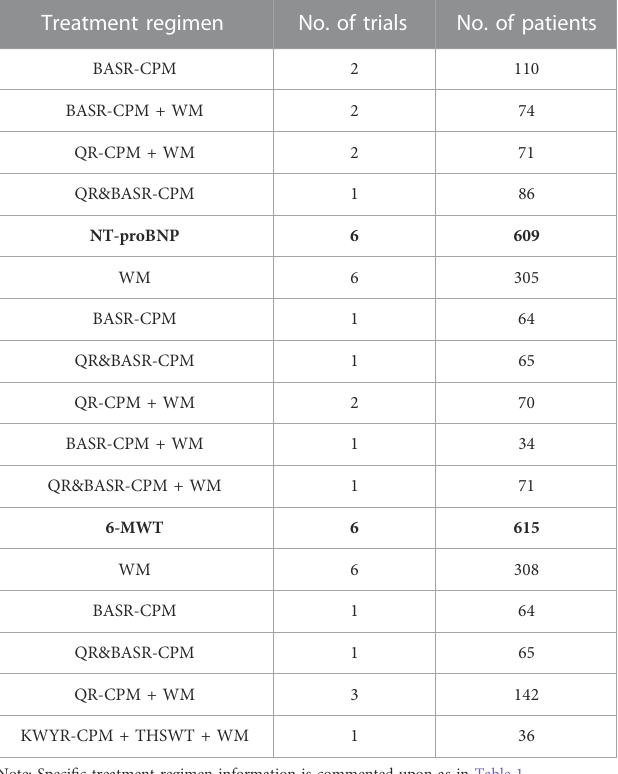
TABLE 3 Detailed information for each treatment regimen of all outcomes. Treatment regimen